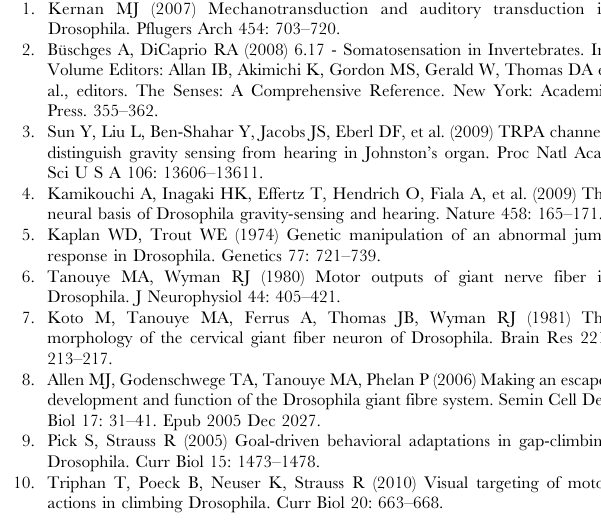
Figure S7 (A) Duty factor. (B) Period. (C) Footprint Alignment. (D) Tetrapod index. (E) Wave Index. (F) Inter-tripod time. Box plots represent the median as the middle line, with the lower and upper edges of the boxes representing the 25% and 75% quartiles, respectively; the whiskers represent the range of the full data set, excluding outliers. Circles indicate outliers. Statistical significance was determined using 2-way-ANOVA with post-hoc t-tests, where *p , 0.05; **p , 0.01; ***p , 0.001. Statistically significant increases or decreases are indicated in red and blue, respectively. (TIF) Figure S8 (A) Average Speed. (B) Swing Duration. (C) Step Length. (D) Swing Speed. (E) Tetrapod Index. (F) Wave Index. Box plots represent the median as the middle line, with the lower and upper edges of the boxes representing the 25% and 75% quartiles, respectively; the whiskers represent the range of the full data set, excluding outliers. Circles indicate outliers. Statistical significance was determined using 3-way-ANOVA with post-hoc t- tests, where *p , 0.05; **p , 0.01; ***p , 0.001. Statistically signif- icant increases or decreases are indicated in red and blue, respectively. (TIF) Table S1 Parameter definitions and units used in the